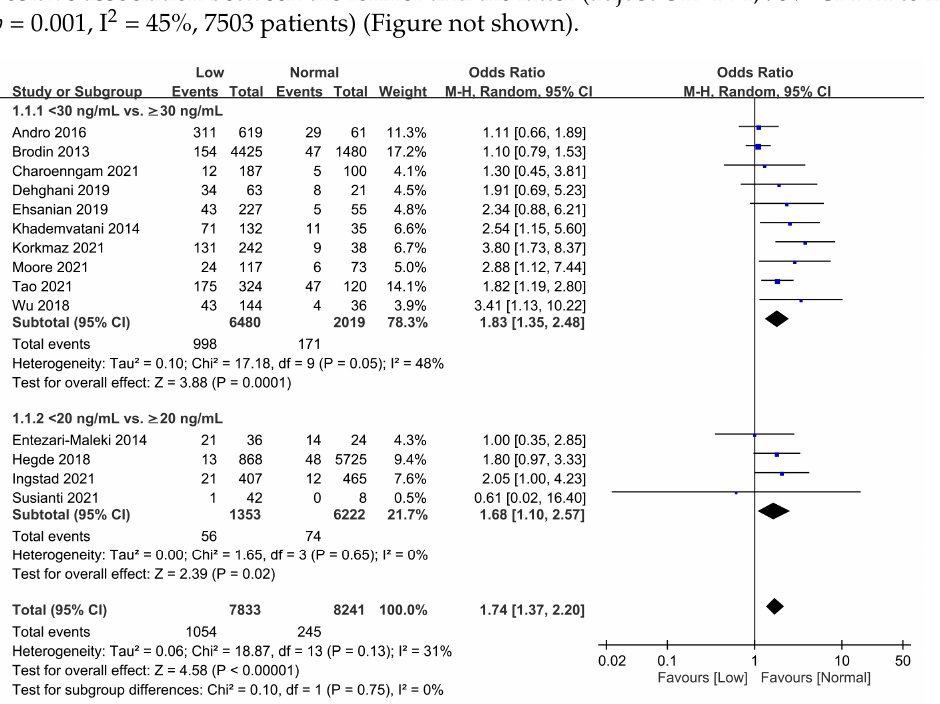
Figure 2. Forest plot comparing the overall risk of venous thromboembolism estimated with odds ratio between individuals with and those without a low vitamin D status. CI, confidence interval; M-H, Mantel-Haenszel.The measure of effect (e.g., an odds ratio) for each of these studies is represented by a square incorporating confidence intervals represented by horizontal lines. The vertical line is “Line of no effect”. The area of each square is proportional to the study’s weight in the meta-analysis. This meta-analysed measure of effect is plotted as a diamond, the lateral points of which indicate confidence intervals for this estimate [18,19,28–39].